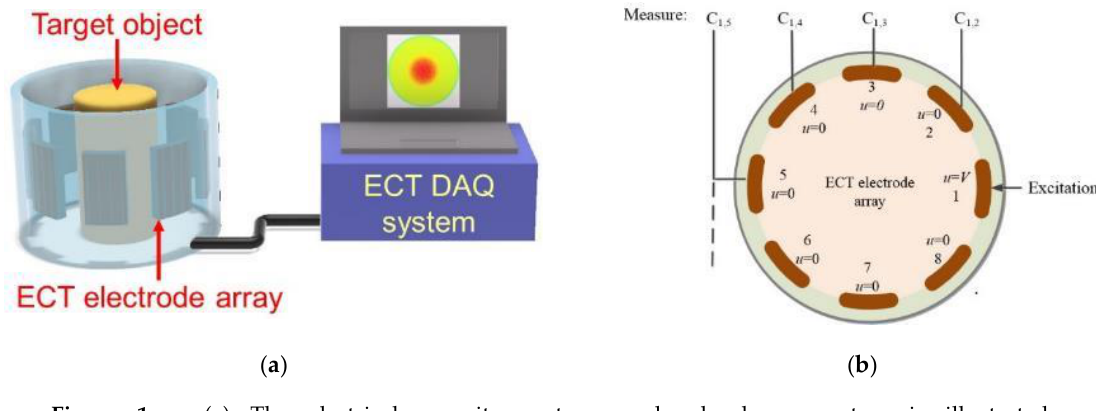
Figure 1. ( a ) The electrical capacitance tomography hardware system is illustrated. ( b ) The cross- section of the ECT electrode array is shown with its electrode numbering scheme. A typical ECT excitation-measurement sequence is also